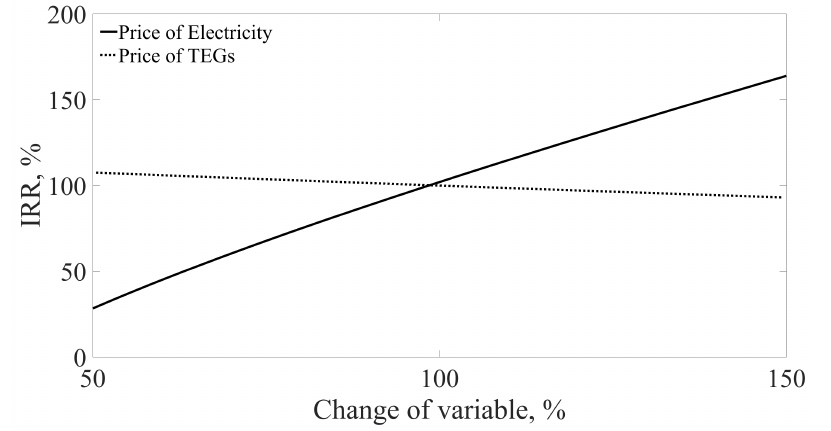
Figure 15. Sensitivity of the internal rate of return of the investment with Material 1 on the price of electricity and that of the TEG construction.